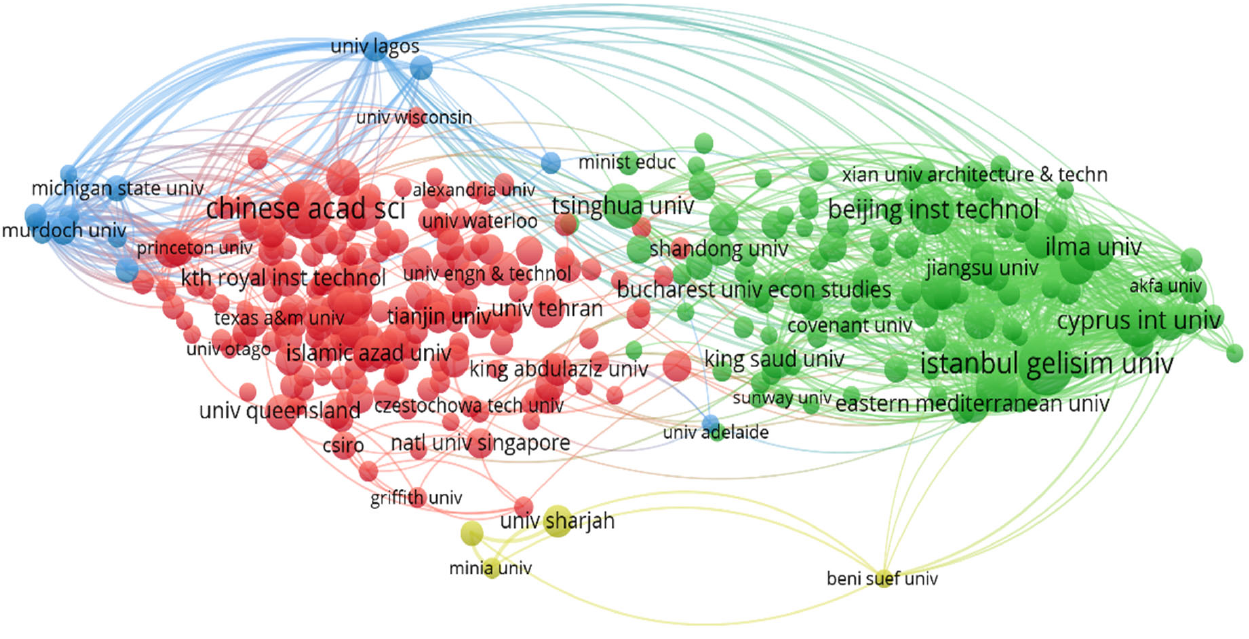
Figure 4. Bibliographic linkage map by authors with at least 30 citations. Source: elaborated on the basis of WoS and VOSviewer. Table 4. Institutions by number of records and region (Top-30).